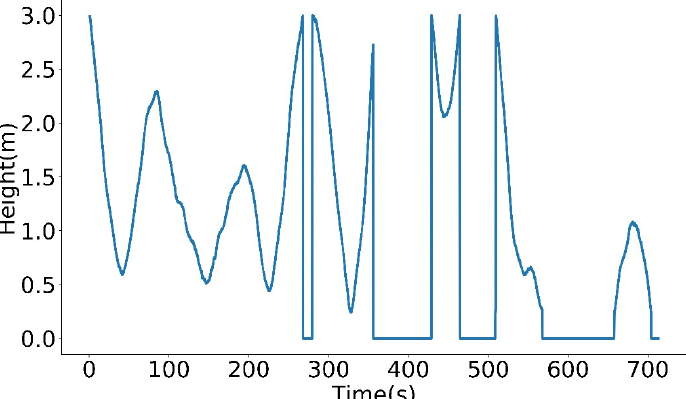
Figure 8. Estimated height away from the seabed in 2020 standardized sea trial.